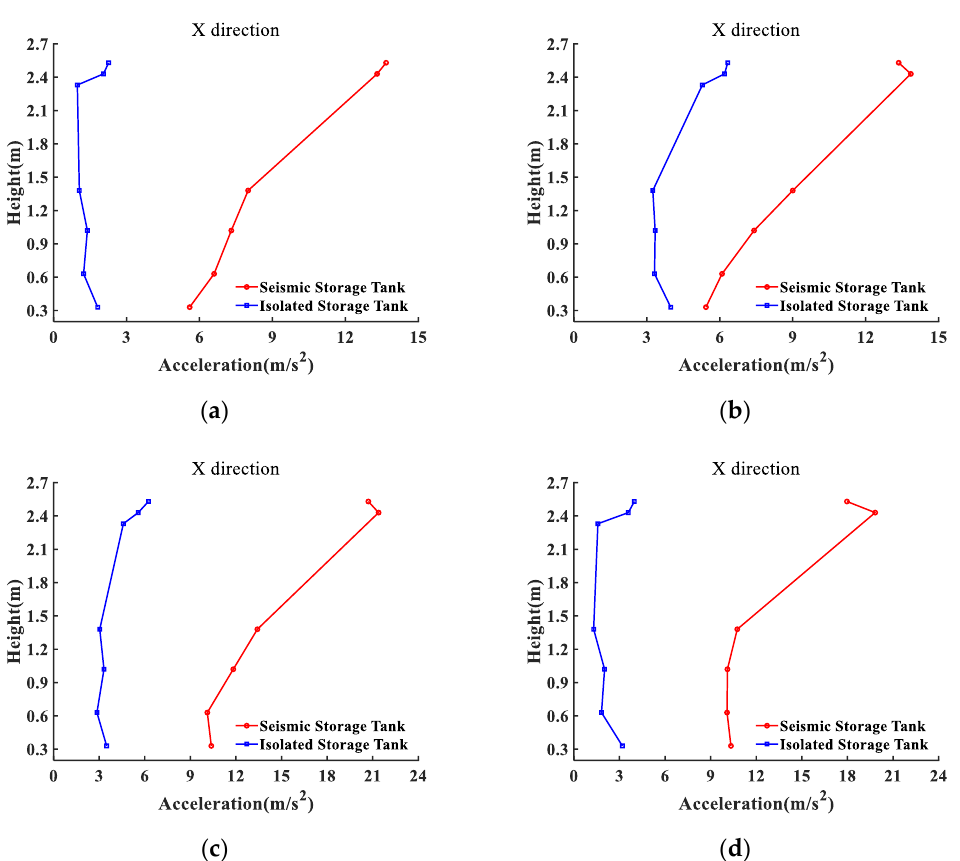
Figure 4. Comparison of peak acceleration in the X-direction of the seismic storage tank: ( a ) Taft wave (XZ direction, 0.50 g); ( b ) Artificial wave (XYZ direction, 0.50 g); ( c ) Wolong wave (XYZ direction, 0.75 g); ( d ) Taft wave (XZ direction, 0.75 g).